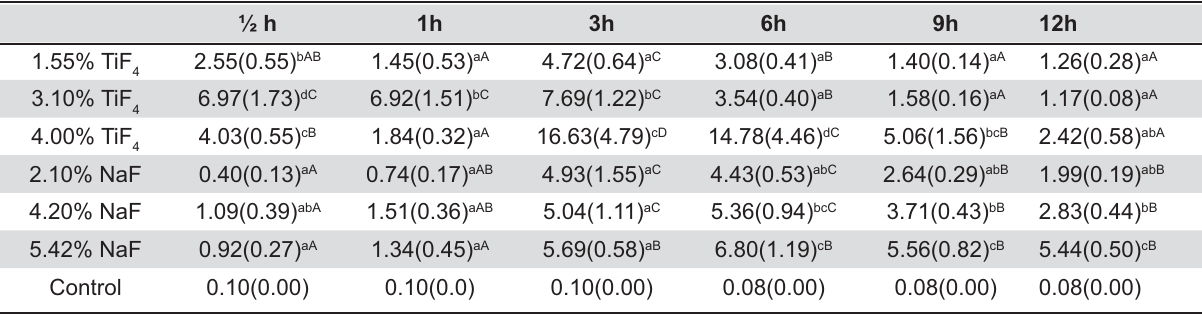
Table 2- (cid:2)(cid:3)(cid:4)(cid:5)(cid:6)(cid:2)>(cid:2)(cid:20)(cid:9)(cid:5)(cid:6)(cid:19)(cid:5)(cid:18)(cid:19)(cid:2)(cid:19)(cid:4)(cid:16)(cid:15)(cid:5)(cid:9)(cid:15)(cid:7)(cid:6)(cid:2)(cid:21)(cid:20)(cid:30)(cid:19)(cid:30)(cid:23)(cid:2)(cid:7)(cid:8)(cid:2)(cid:17)(cid:12)(cid:7)(cid:18)(cid:15)(cid:19)(cid:4)(cid:2)(cid:18)(cid:4)(cid:14)(cid:4)(cid:5)(cid:20)(cid:4)(cid:2)(cid:21)(cid:22)(cid:22)(cid:13)(cid:23)(cid:2)(cid:8)(cid:18)(cid:7)(cid:13)(cid:2)(cid:9)(cid:10)(cid:4)(cid:2)(cid:4)(cid:24)(cid:22)(cid:4)(cid:18)(cid:15)(cid:13)(cid:4)(cid:6)(cid:9)(cid:5)(cid:14)(cid:2)(cid:16)(cid:5)(cid:18)(cid:6)(cid:15)(cid:20)(cid:10)(cid:4)(cid:20)(cid:2)(cid:15)(cid:6)(cid:2)(cid:5)(cid:18)(cid:9)(cid:15)(cid:28)(cid:11)(cid:15)(cid:5)(cid:14)(cid:2)(cid:20)(cid:5)(cid:14)(cid:15)(cid:16)(cid:5)(cid:2)(cid:5)(cid:9)(cid:2) each time